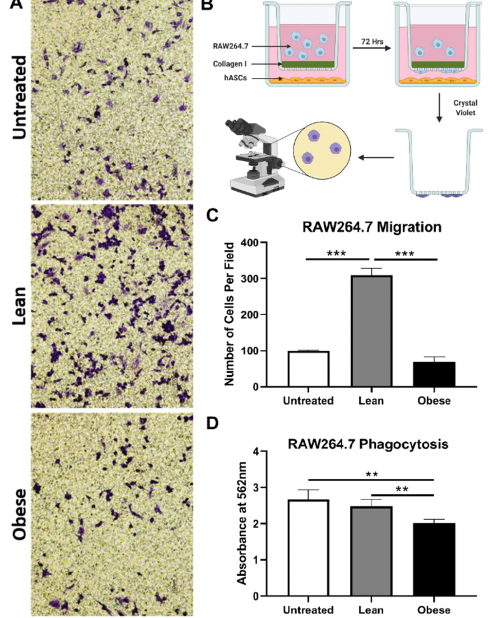
Figure 3. LnASCs and ObASCs differentially alter the migration and phagocytotic abilities of RAW264.7 cells. ( A ) Representative scheme of RAW264. 7 cells following migration through a collagen-coated Transwell in the presence of LnASCs or ObASCs. Created with Biorender.com ( B ) Diagram of migration assay process including staining and imaging. ( C ) Quantification of the cells migrated per field based on three randomly chosen fields for each Transwell migration performed. ( D ) Phagocytosis of E. coli -substrate by RAW264.7 cells following 48-h treatment with LnASC or ObASC conditioned media. Values are presented as means (N = 3) ± SD of three independent experiments using one-way ANOVA followed by Dunnett’s multiple comparison test. Statistical differences between the means are marked with ** p < 0.01, *** p <